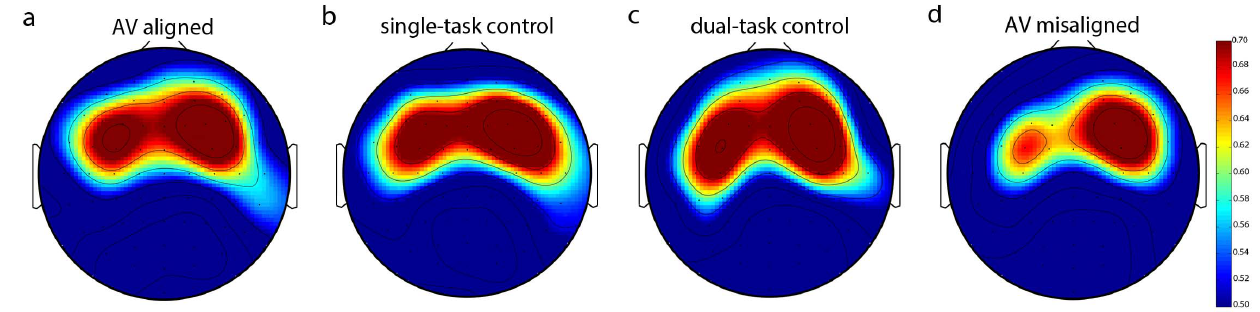
Figure 3. Scalp topography of group average ASSR amplitudes in the (a) AV-aligned, (b) single-task control, (c) dual-task control, and (d) AV-misaligned conditions. Note that ASSR in the left-frontal ROI is reduced only in the AV-misaligned condition (d). Bar to the right indicates scale.